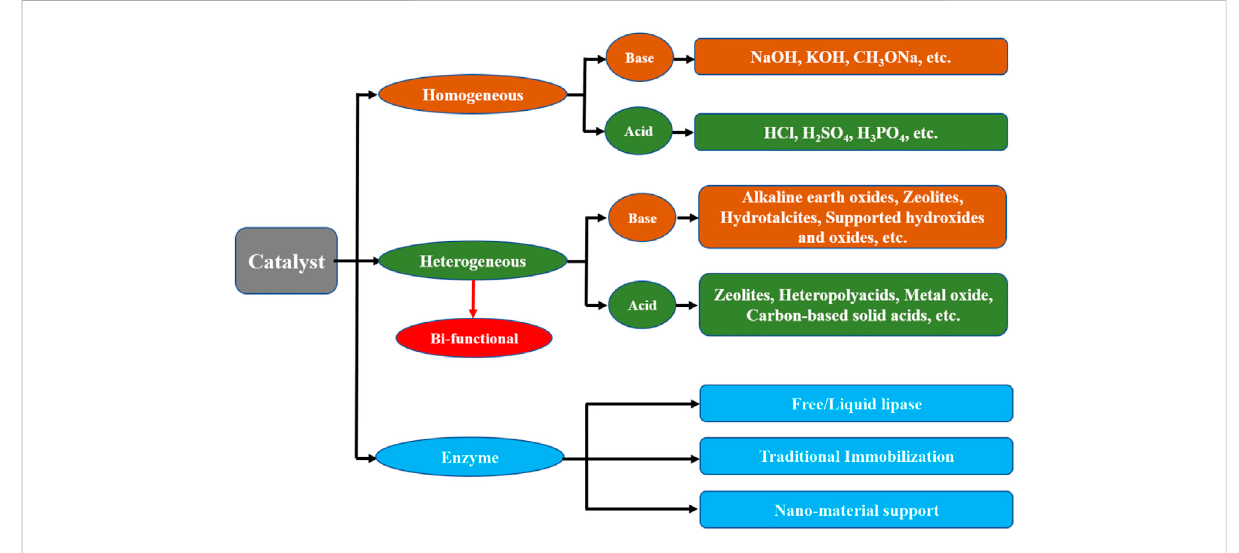
FIGURE 1 Classi fi cation of catalysts for biodiesel